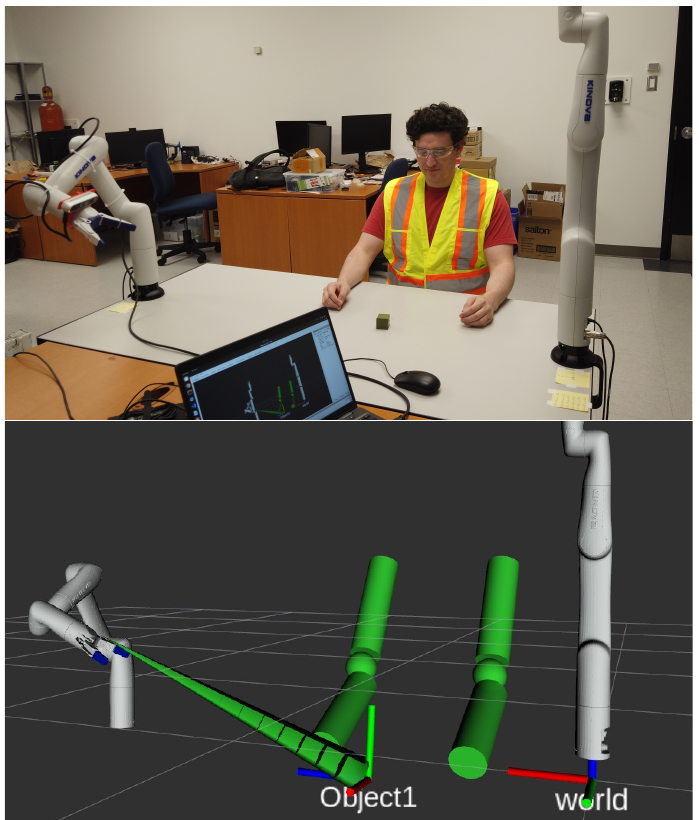
Figure 3. View of the experimental setup: at the top —a photo of the manipulators, camera, operator arms, and the target object; at the bottom —the visualization (in Rviz) of the same scene, with the virtual obstacles in green.